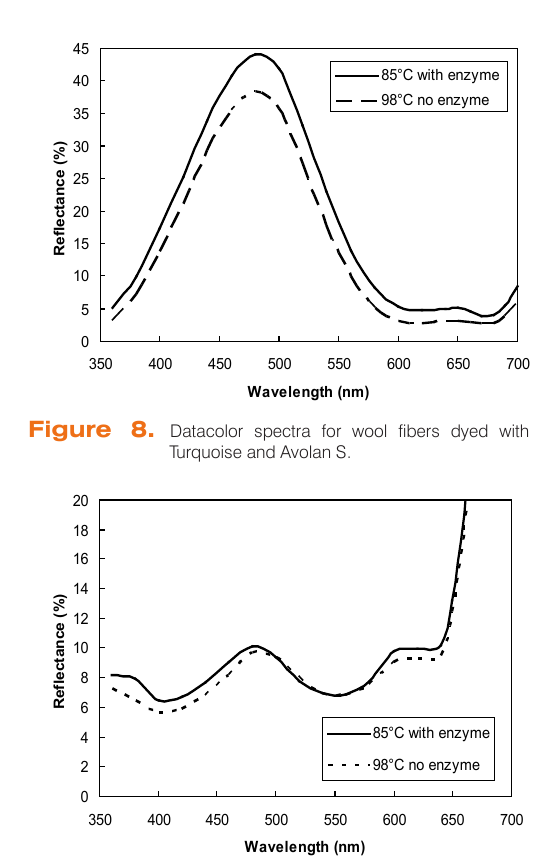
Figure 9. Datacolor spectra for wool fibers dyed with dye triad.